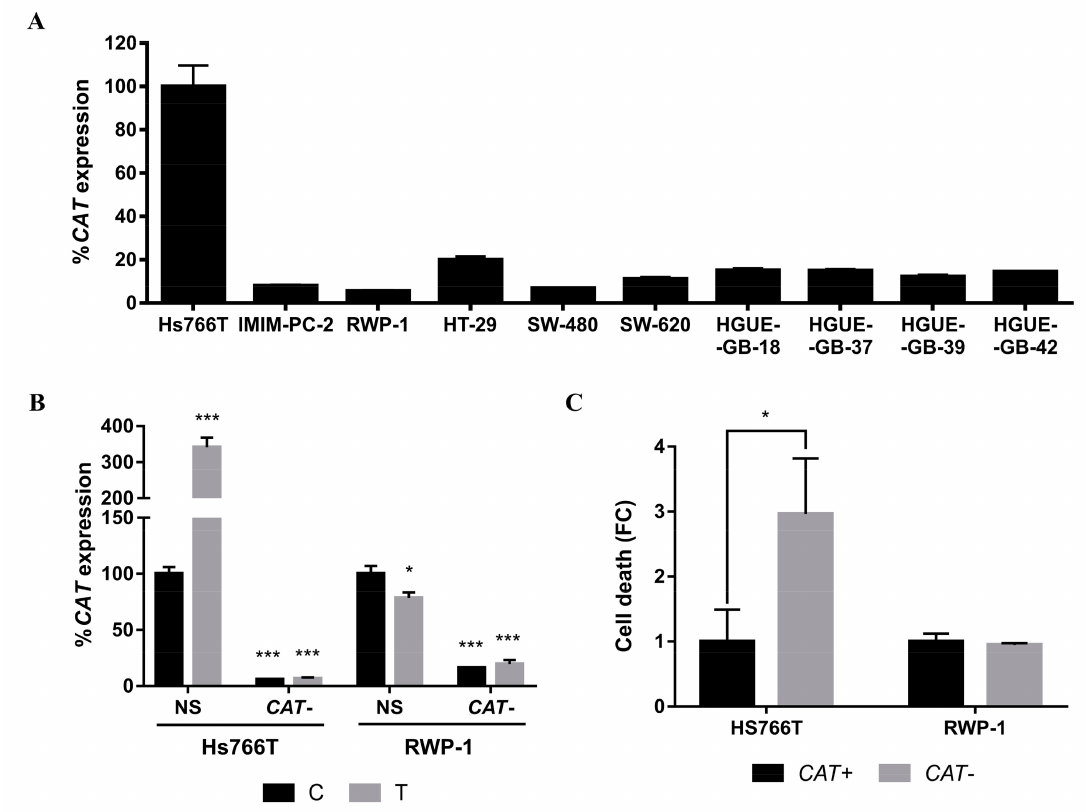
Figure 8. Role of CAT in the resistance to CLytA-DAAO-induced cell death. ( A ) CAT expression in pancreatic and colon carcinoma and glioblastoma cell lines. Data represent the percentage of catalase expression, normalized with respect to Hs766T ± SD with n ≥ 3. ( B ) CAT expression in Hs766T and RWP-1 cell lines, control (C) and treated with CLytA-DAAO and D-Ala (T), after being transfected with a non-specific (NS) or a catalase siRNA (CAT − ). Data represent the percentage of catalase expression, normalized with respect to control transfected with a non-specific siRNA ± SD with n ≥ 3. ( C ) Hs766T and RWP-1 cell death after being treated with CLytA-DAAO and D-Ala and transfected with a non-specific (CAT + ) or a CAT siRNA (CAT − ) for 24 h. Data represent the cell death increase ± SD with n ≥ 3. * indicates a p -value < 0.05 and *** p -value <